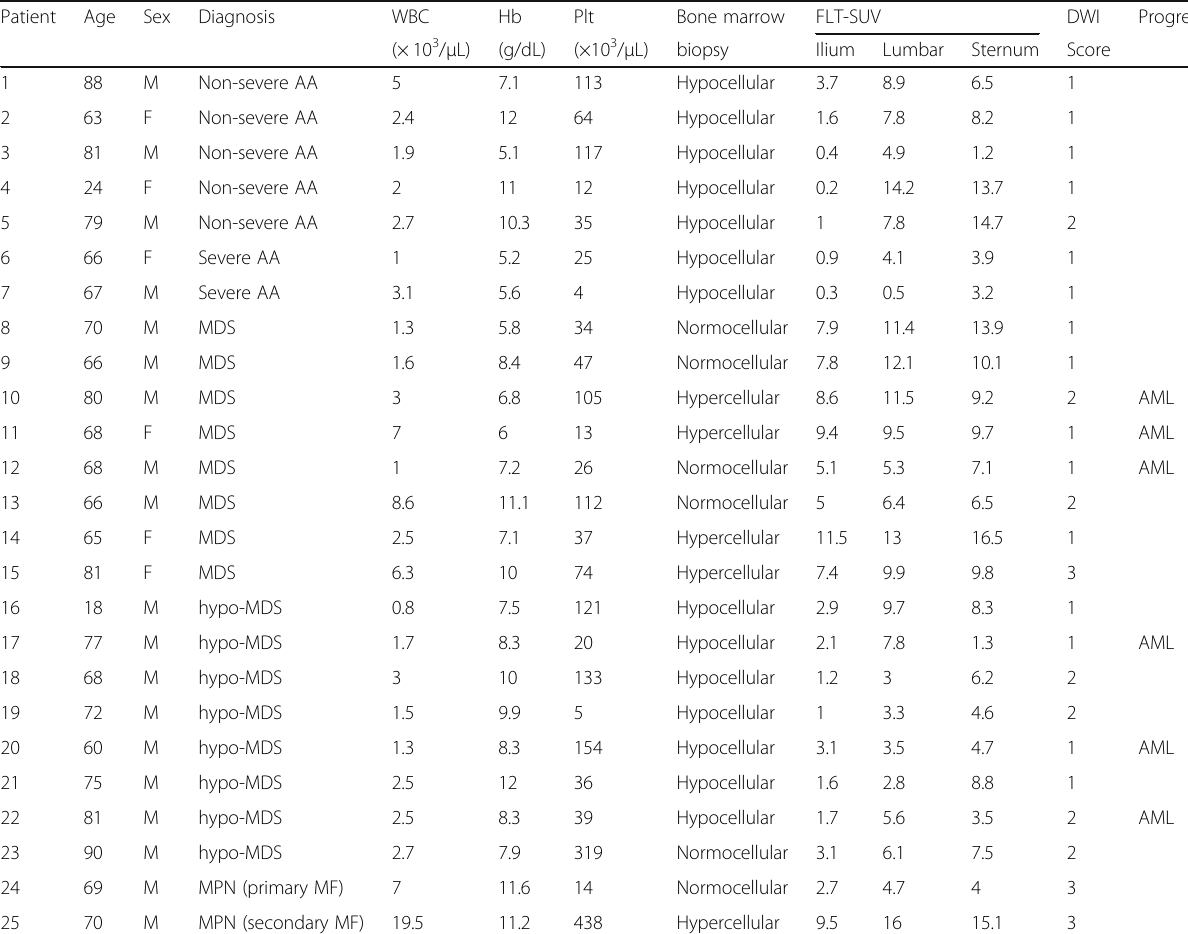
Table 1 BMFS patient characteristics